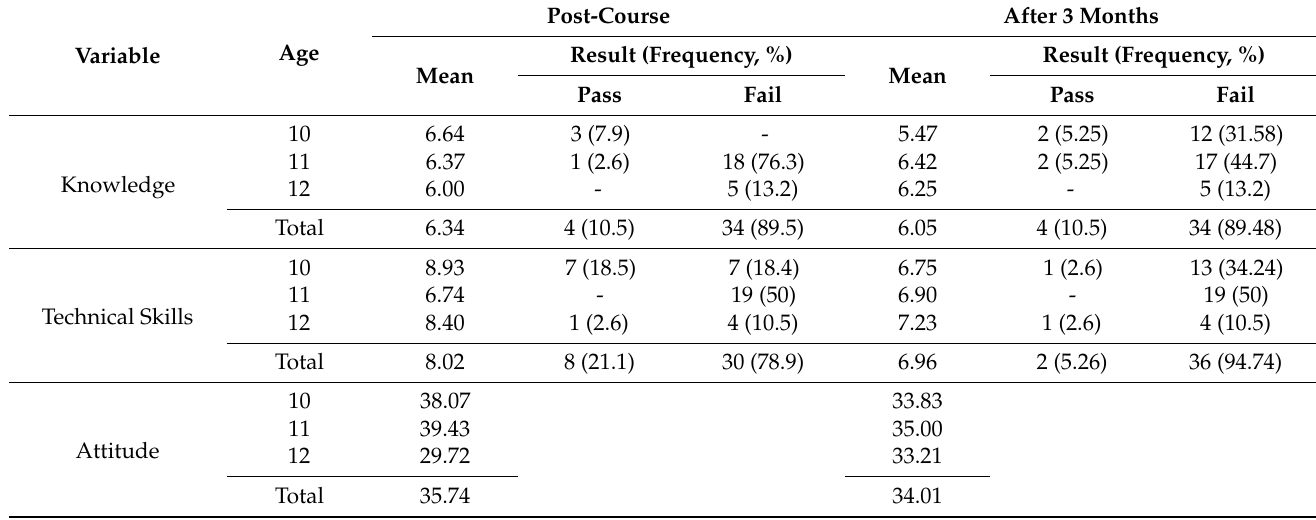
Table 2. Mean scores and success rate of knowledge, technical skills, and attitude towards CPR post course and after 3 months.